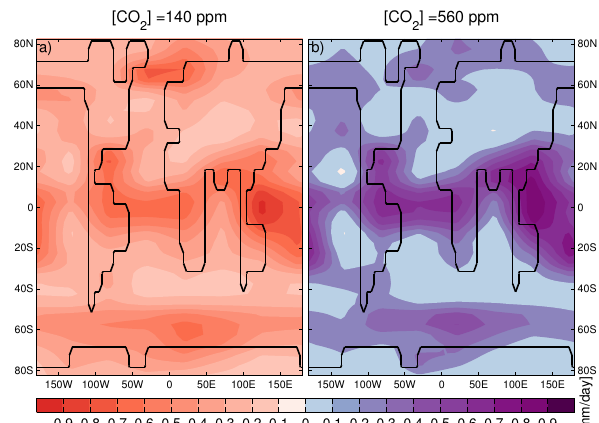
Fig. 3. Ensemble-mean annual temperature anomalies relative to the preindustrial climate ( R - C ) for (a) 1 experiments with prescribed vegetation from the control. All values are significant at the 95% level.